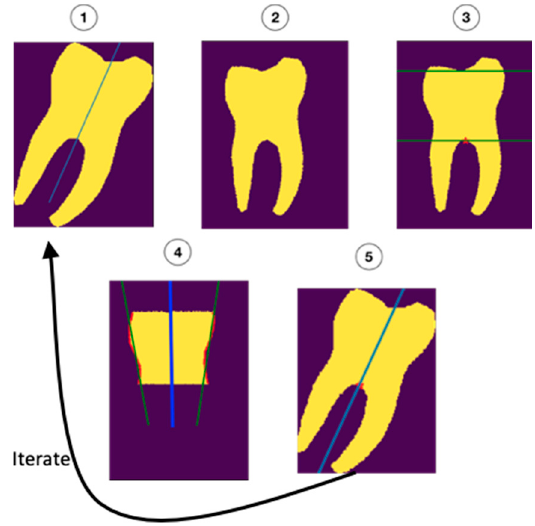
Figure 2. Visual representation of the orientation estimation (iterative algorithm) by the network. The software allowed for the user to evaluate and manually refine the final molar angulations by either: (1) editing the segmentation map as demonstrated in Figure 3a (drag, cut or re-create segmentation contours), and (2) manually dragging the start and end points of the regression lines on the mesial and distal side of the molars as illustrated in Figure 3b.